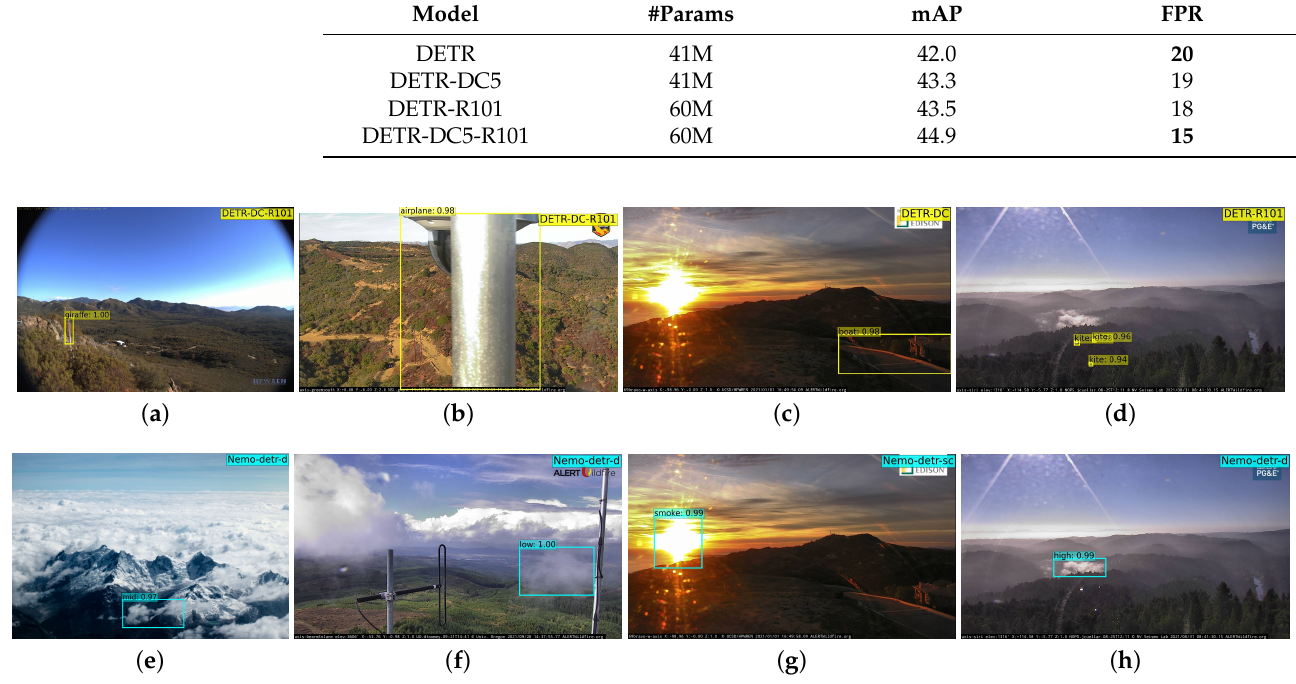
Table 4. Evaluation of DETR models on the COCO validation set (denoted by the mAP) and false alarm performance against images with no target objects (denoted by the FPR). We mainly transferred weights from DETR with 42% AP on the COCO benchmark. This shows that even the highest- performing object detector with a state-of-the-art 44.9% mAP still creates 15 false alarms when used against images with no COCO object. This shows that our smoke detector with 21 false alarms against a dataset with smoke-like objects is already performing well and as expected. Model